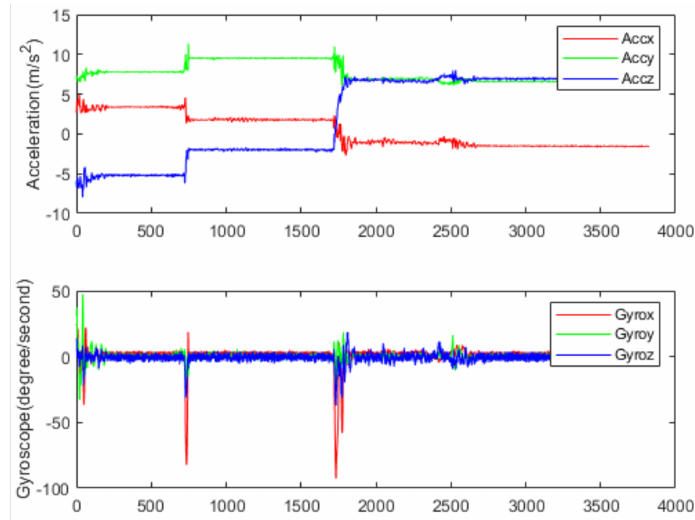
Figure 7. Data collected by accelerometer and gyroscope on